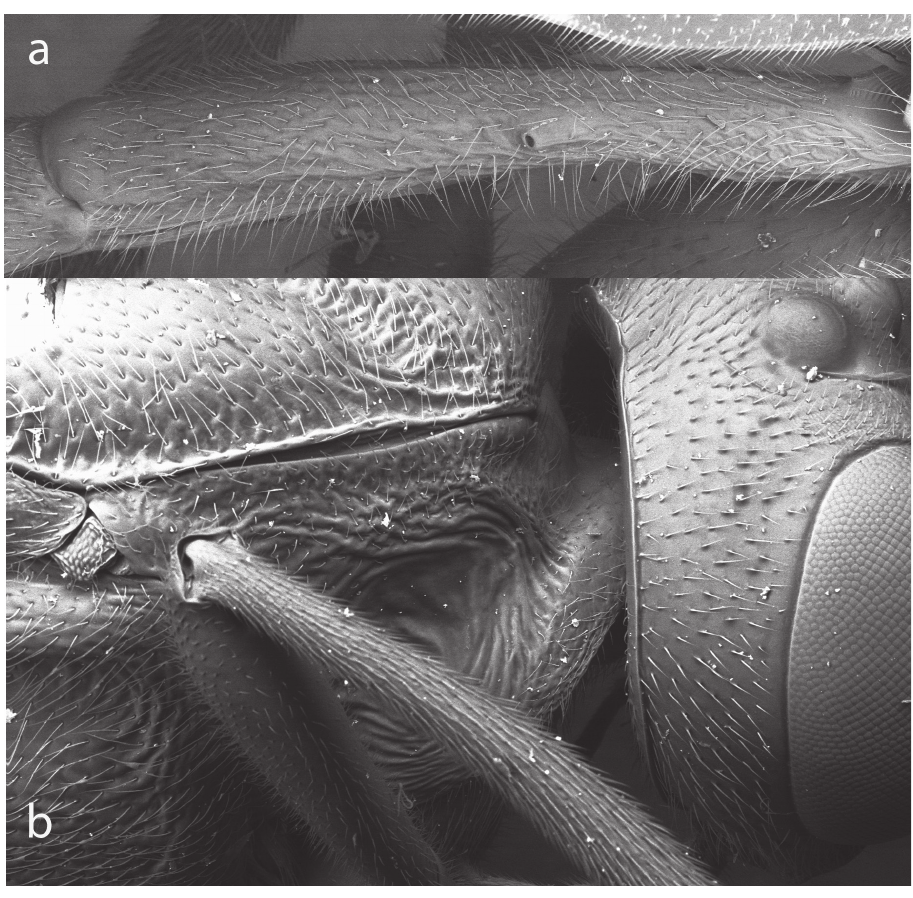
Figure 7. First tergite a and pronotum b of Bicurta sinica tion with short transverse wrinkles. Speculum relatively large. Mesosternum densely punctate. Median longitudinal suture of mesosternum distinct, slightly widening pos- teriorly. Metapleuron scabrous, with irregular, elongate punctures. Metasternum elon- gate, approximately 0.6 × as long as mesosternum, with distinct median longitudinal carina and irregular transverse wrinkles. Wing hyaline with slight grey tinge. 2 rs-m basad 2 m-cu by 0.66 × length of 2 rs-m . Vein 2- Cu as long as 2 cu-a . Hind coxa with dis- tinct punctures. Ratio of length of hind tarsomeres 1:2:3:4:5 is 10.0:4.2:2.9:2.0:4.2. Propodeum between carinae with distinct transverse wrinkles. Propodeal spiracle 1.4 × as long as maximum width, distance to pleural carina approximately 2.6 × as long as distance to lateral longitudinal carina. Metasoma. First tergum approximately 5 × as long as apical width, with longitu- dinal wrinkles, between wrinkles with punctures; without longitudinal carina; spiracle convex, located at basal 0.42. Second tergum about 2.0 × as long as apical width, slightly widened posteriorly, with sparse, indistinct punctures. Third tergum with even,